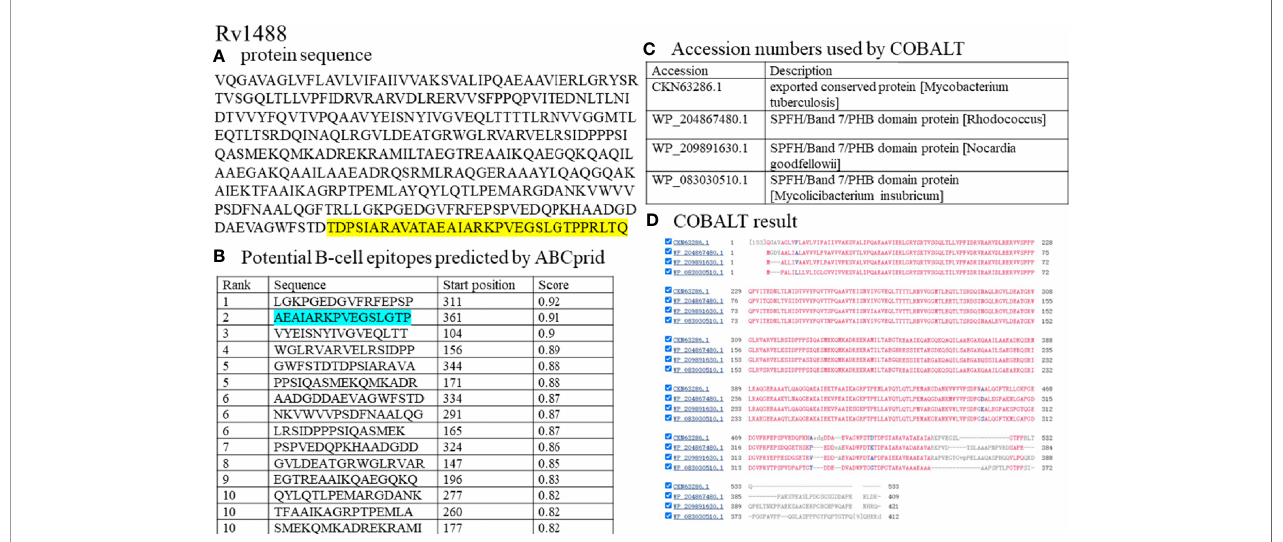
FIGURE 2 | Synthesizing the polypeptide of Rv1488 antigen with dominant B-cell epitopes and non-conserved fragments. (A) the full protein sequence of Rv1488 antigen. Sequences colored in yellow represented the polypeptide of Rv1488 Synthesized. (B) ABCprid software was used to screen potential B-cell epitopes. Residues colored in green represented dominant B-cell epitopes predicted. (C) The accession numbers of bacteria used for COBALT software analysis; (D) The result of COBALT software analysis. This view showed residue conservation: red for conserved residues, blue for columns with no gaps, and gray for columns containing gaps.